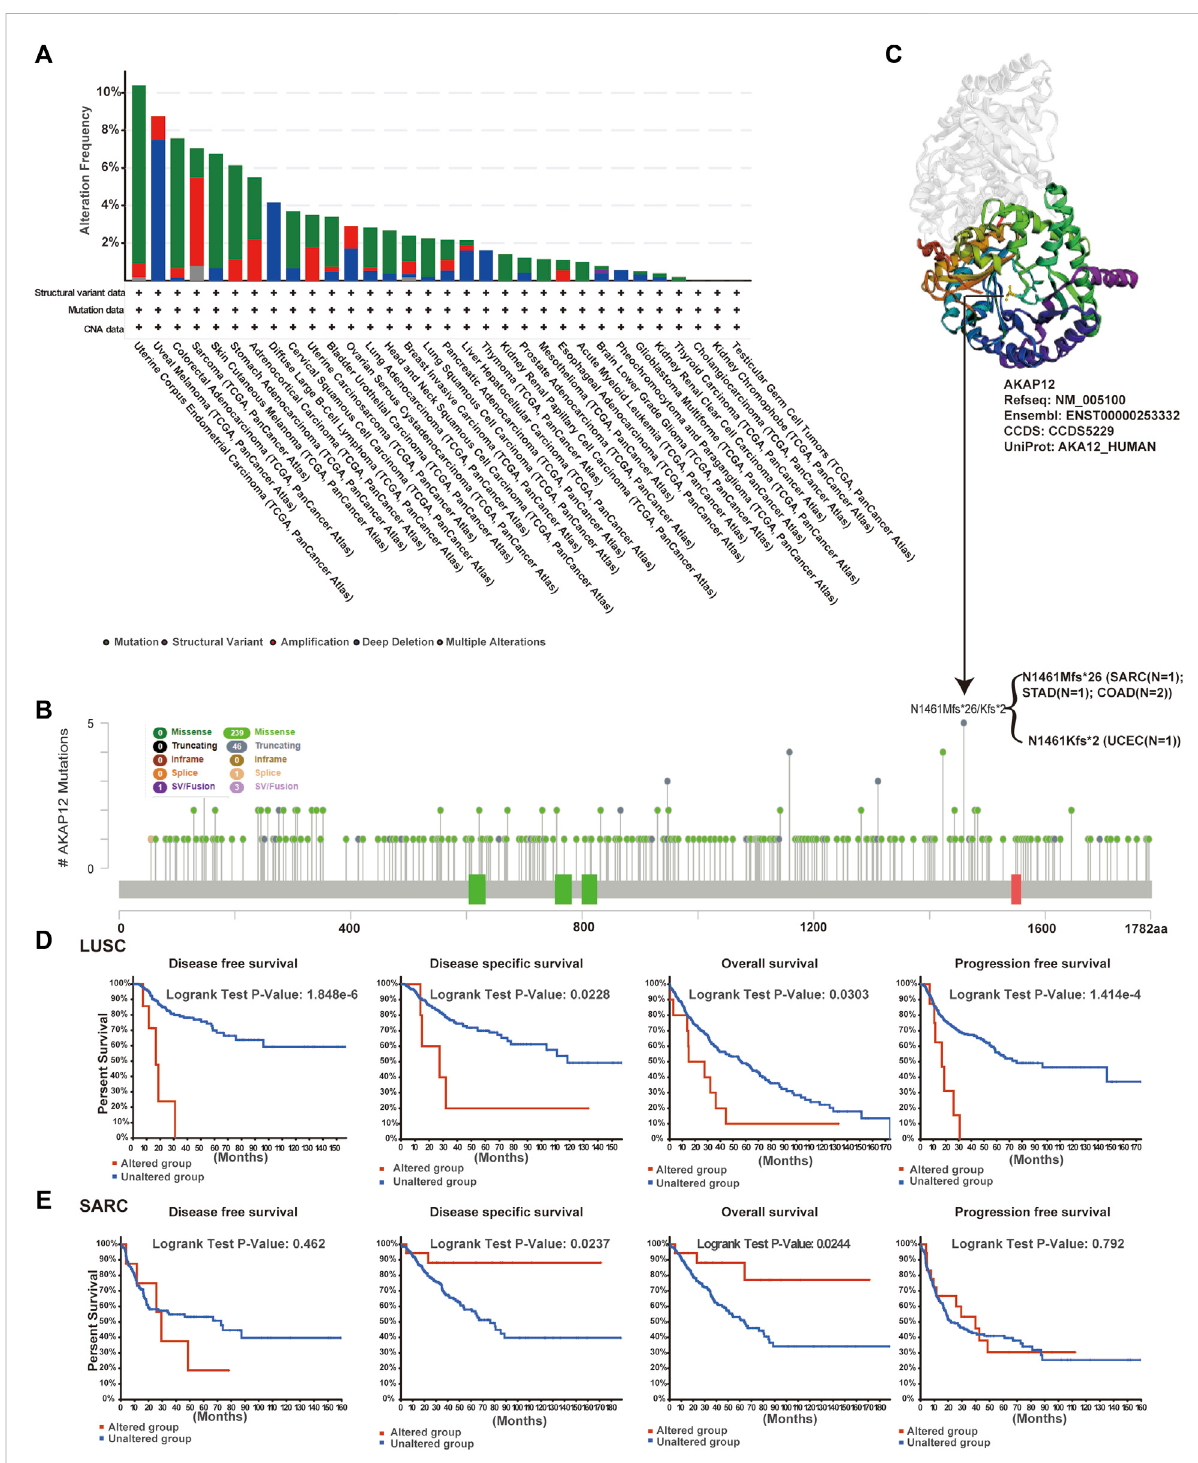
FIGURE 4 Mutation status of AKAP12 in TCGA tumors. Mutation states of AKAP12 in TCGA tumors were analyzed utilizing the cBioPortal portal. Genetic alteration type and frequency (A) , and mutation site (B) are exhibited. (C) The mutation site (N1461) was displayed in the 3D structure of AKAP12. (D – E) CharacterizationoftherelationshipbetweenAKAP12alterationstatusanddisease-free,disease-speci fi c,overall,andprogression-freesurvival of LUSC and